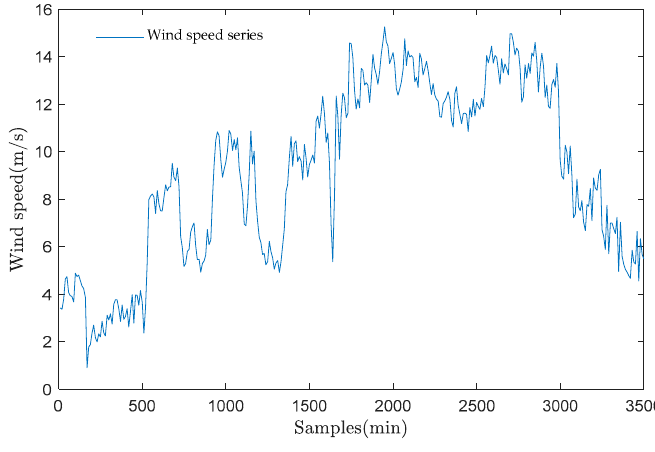
Energies 2020 , 13 , x FOR PEER REVIEW Figure 6. The original wind speed series. Figure 6. The original wind speed series.